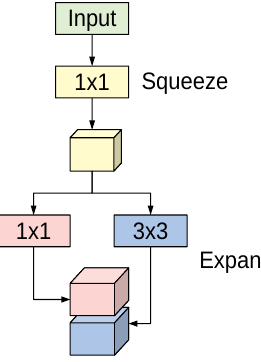
Figure 1. The fire module used in SqueezeNet.